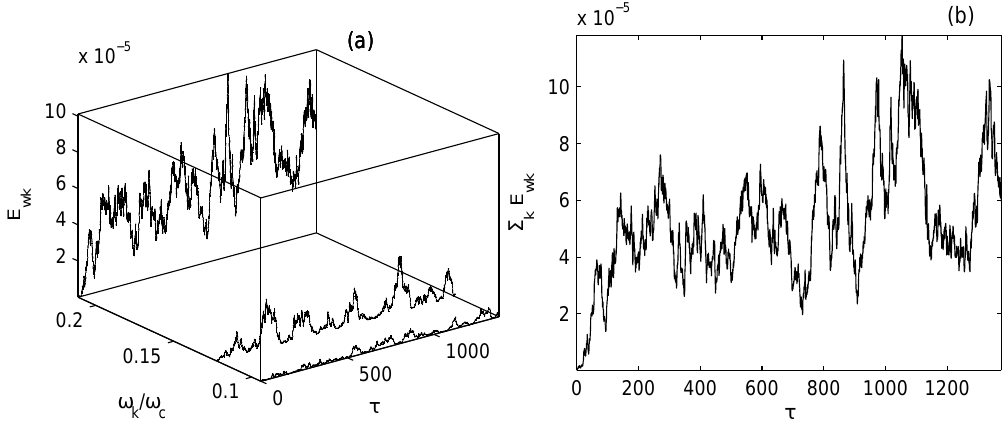
Fig. 3. Interaction of three waves with a particle distribution in the presence of a suprathermal tail of electrons extending in the parallel direction v z > 0. The waves’ frequencies and wave vectors are satisfying to the matching conditions of the three-waves resonant decay: + ω k = k 1 + k 2 and ω k = ω k k 2 ; the coupling between the three waves is neglected. (a) Variation as a function of the normalized time τ 1 (cid:12) (cid:12) (cid:12) (cid:12) ϕ 2 of the normalized wave energy density E wk (proportional to (cid:12) (cid:12) ) of each of the three waves (each wave is indicated by its normalized k frequency ω k /ω c ) and (b) of the total normalized energy density P k E wk . The electron distribution is modeled by a maxwellian in the perpendicular direction and by a thermal bulk and a suprathermal tail in the parallel direction. The main normalized parameters are the following: p = 0 . 0625, k = ( k x ,k y ,k z ) = ( 0 . 556 , − 0 . 111 , 0 . 125 ) , k 1 = ( 0 . 222 , 0 . 444 , 0 . 0625 ), k 2 = ( 0 . 333 , − 0 . 556 , 0 . 0625 ) , ω k /ω c = 0 . 211 , ω k /ω c = 0 . 122 , ω k /ω c = 0 . 0942 , 1ω/ω c ’ 0 . 005 (frequency mismatch) , v R (m = 0 ) = 1 . 7 , v R 1 (m = 0 ) = 1 . 9 , v R 2 (m = 0 ) = 1 . 5 (Landau m = 0 1 2 normalized resonant velocities for each of the three waves) , v R (m =− 1 ) = 9 . 7 ,v R 1 (m =− 1 ) = 17 . 9 , v R 2 (m =− 1 ) = 17 . 5 (anomalous cy- clotron m =− 1 resonant velocities) , v R (m = 1 ) =− 6 . 3 , v R 1 (m = 1 ) =− 14 , v R 2 (m = 1 ) =− 14 . 5 (normal cyclotron m = 1 resonant velocities), N =